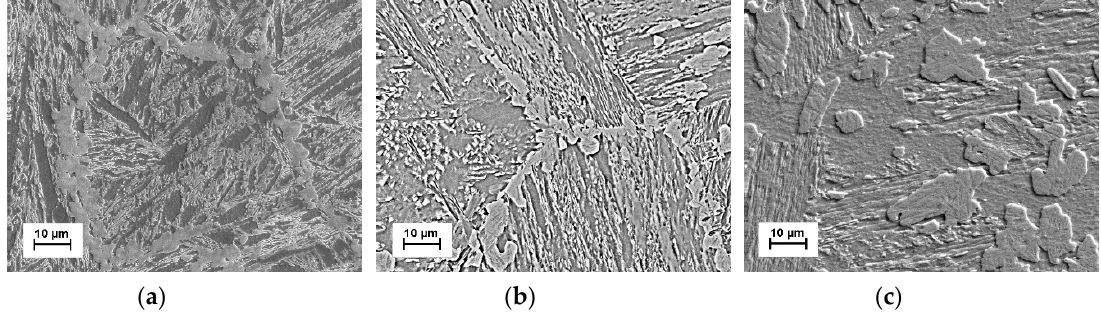
= 2.5 s; ( b ) t = 15 s; ( c ) t = 30 s (M = 1000 × , 2% HNO 8 / 5 8 / 5 8 / 5